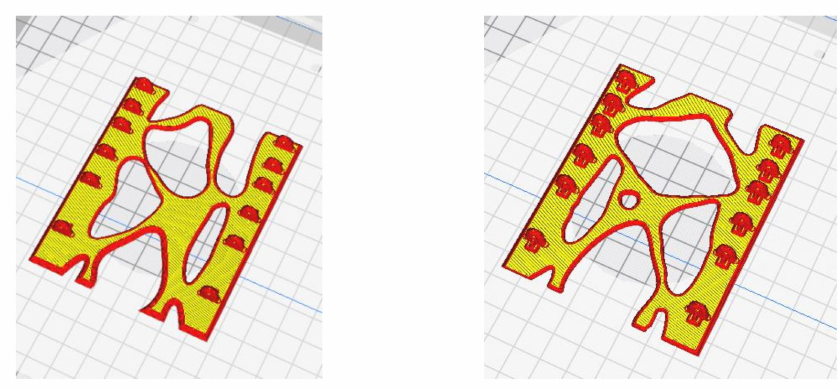
Figure 9. Nanosat optimized ( left ) and ( right ) side structures.